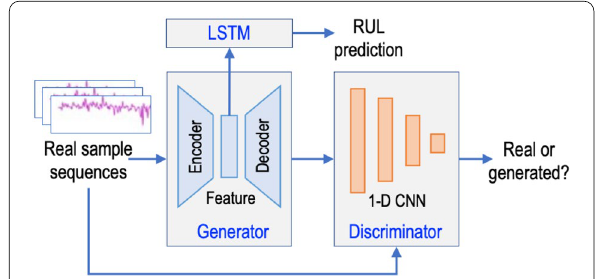
Figure 22 RUL prediction based on GAN and LSTM, adapted from Ref. [125] Figure 23 Attention-based RUL prediction, adapted from Ref.